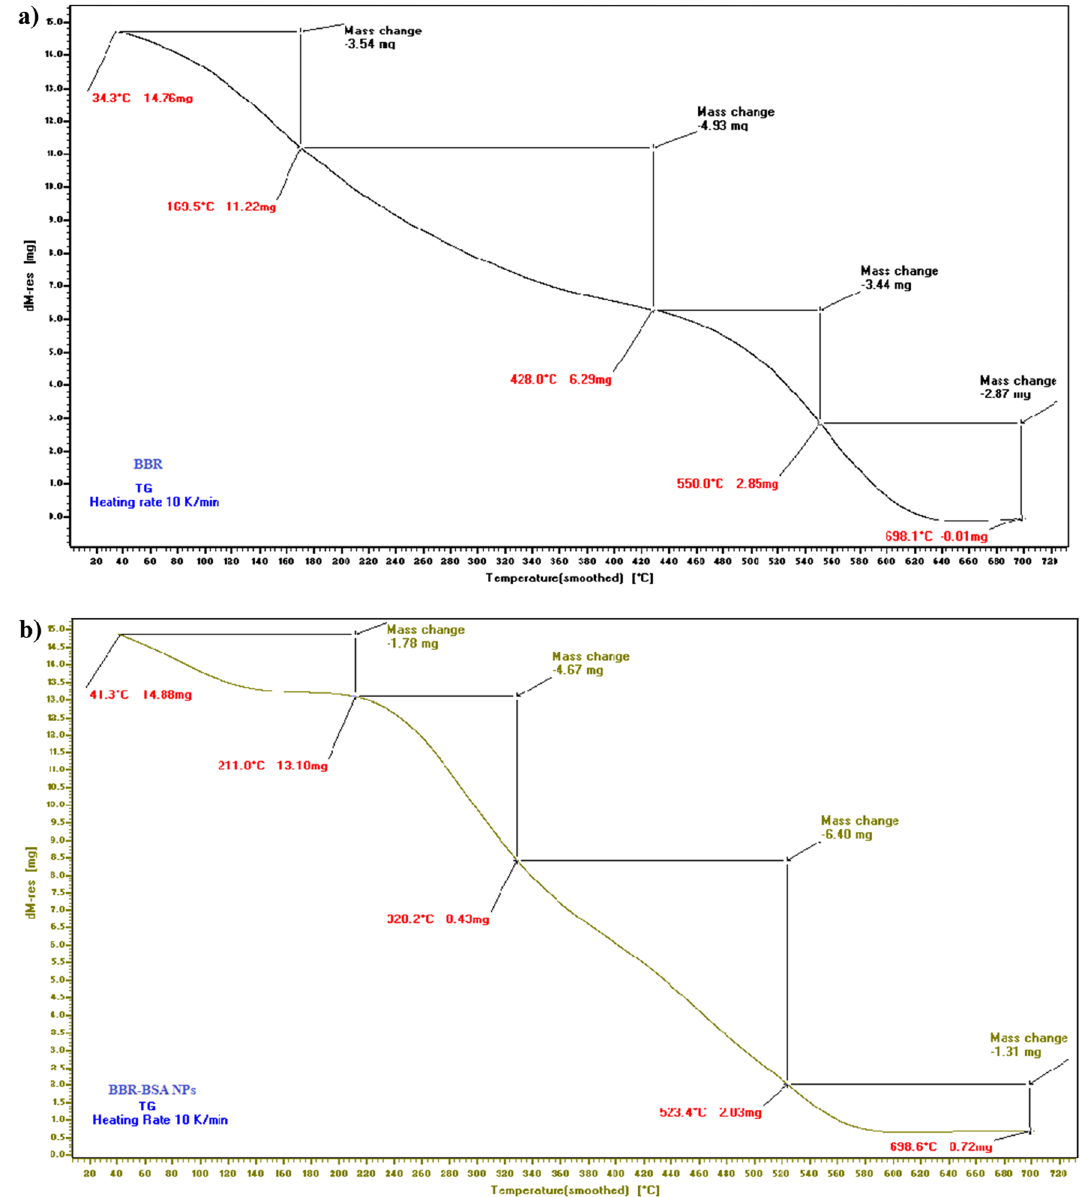
Figure 3. The TGA thermograms of standard BBR-chloride ( a ) and BBR-BSA NPs ( b